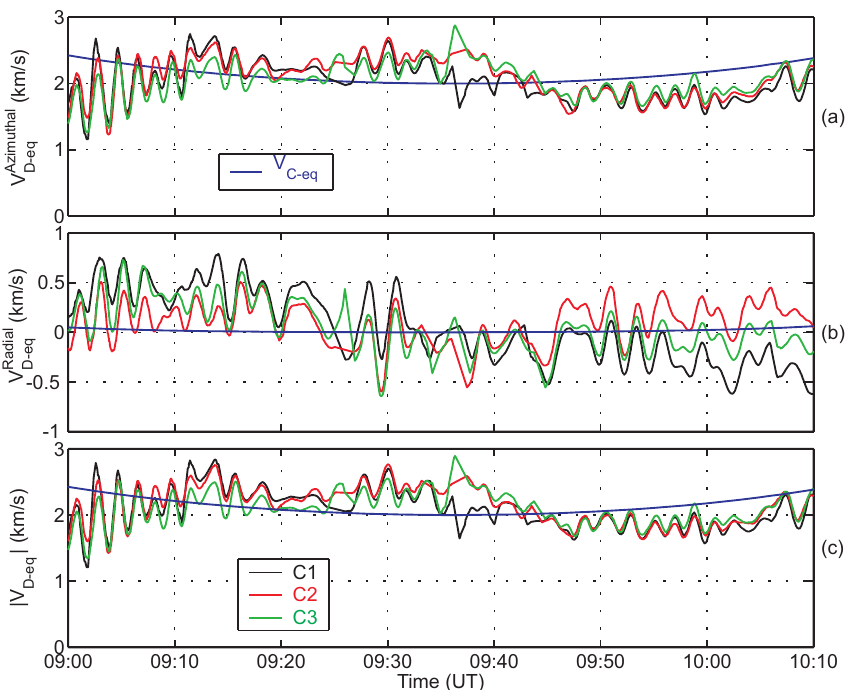
Fig. 5. Electron drift velocity V D − eq measured by EDI and projected onto the magnetic equatorial plane plotted in azimuthal (a) , radial (b) and magnitude (c) coordinates as a function of time for C1, C2 and C3 during the plasmasphere crossing of 7 May 2002, with the co-rotation velocity V C − eq also projected onto the same plane (blue